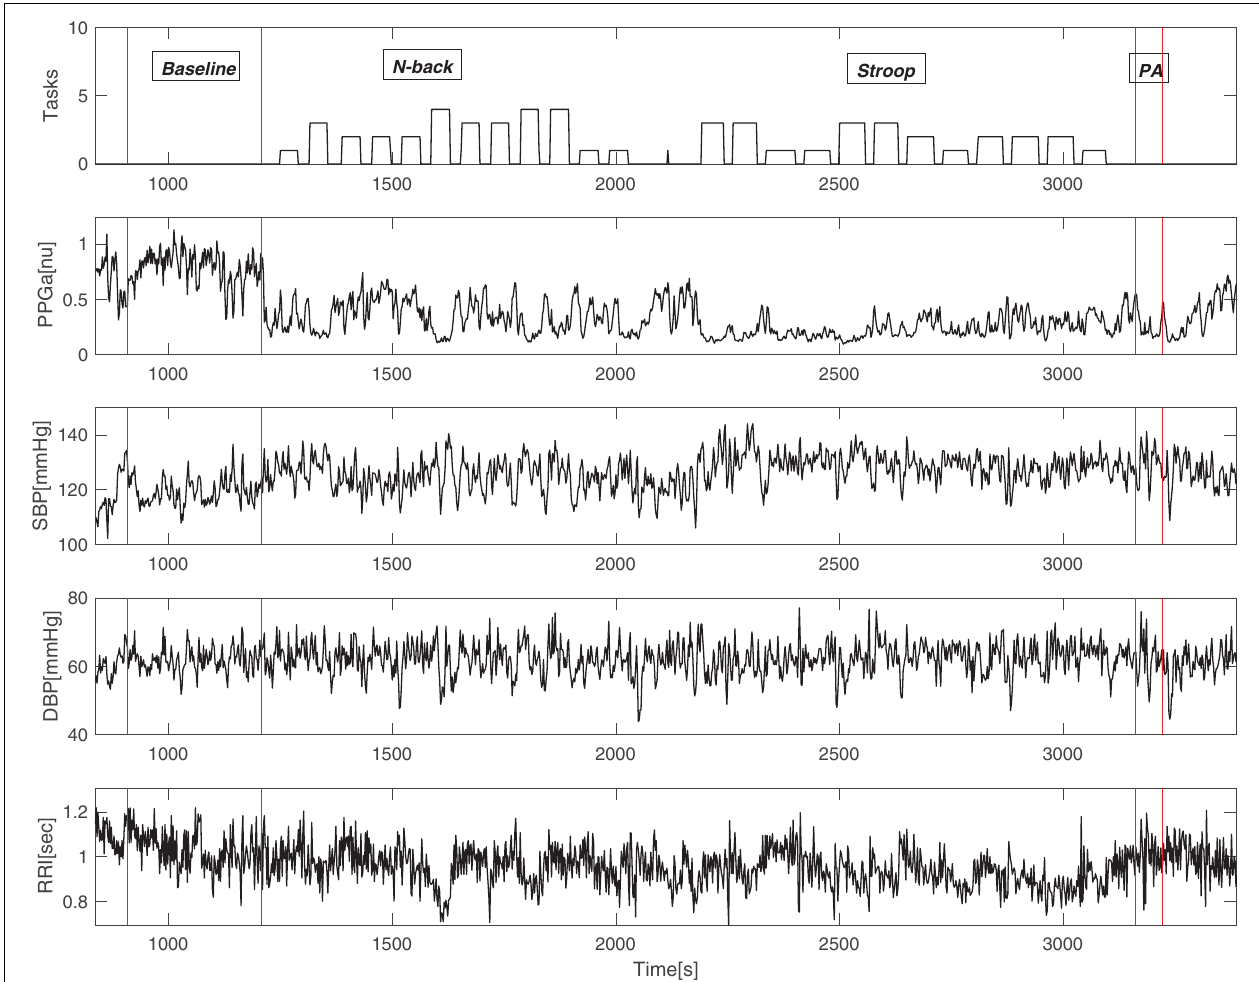
FIGURE 3 | An example of cardiovascular variables during the mental stress protocol of a single subject. “Tasks” (top panel) displays the output of the E-prime software where the height of the bars represents the difficulty of the